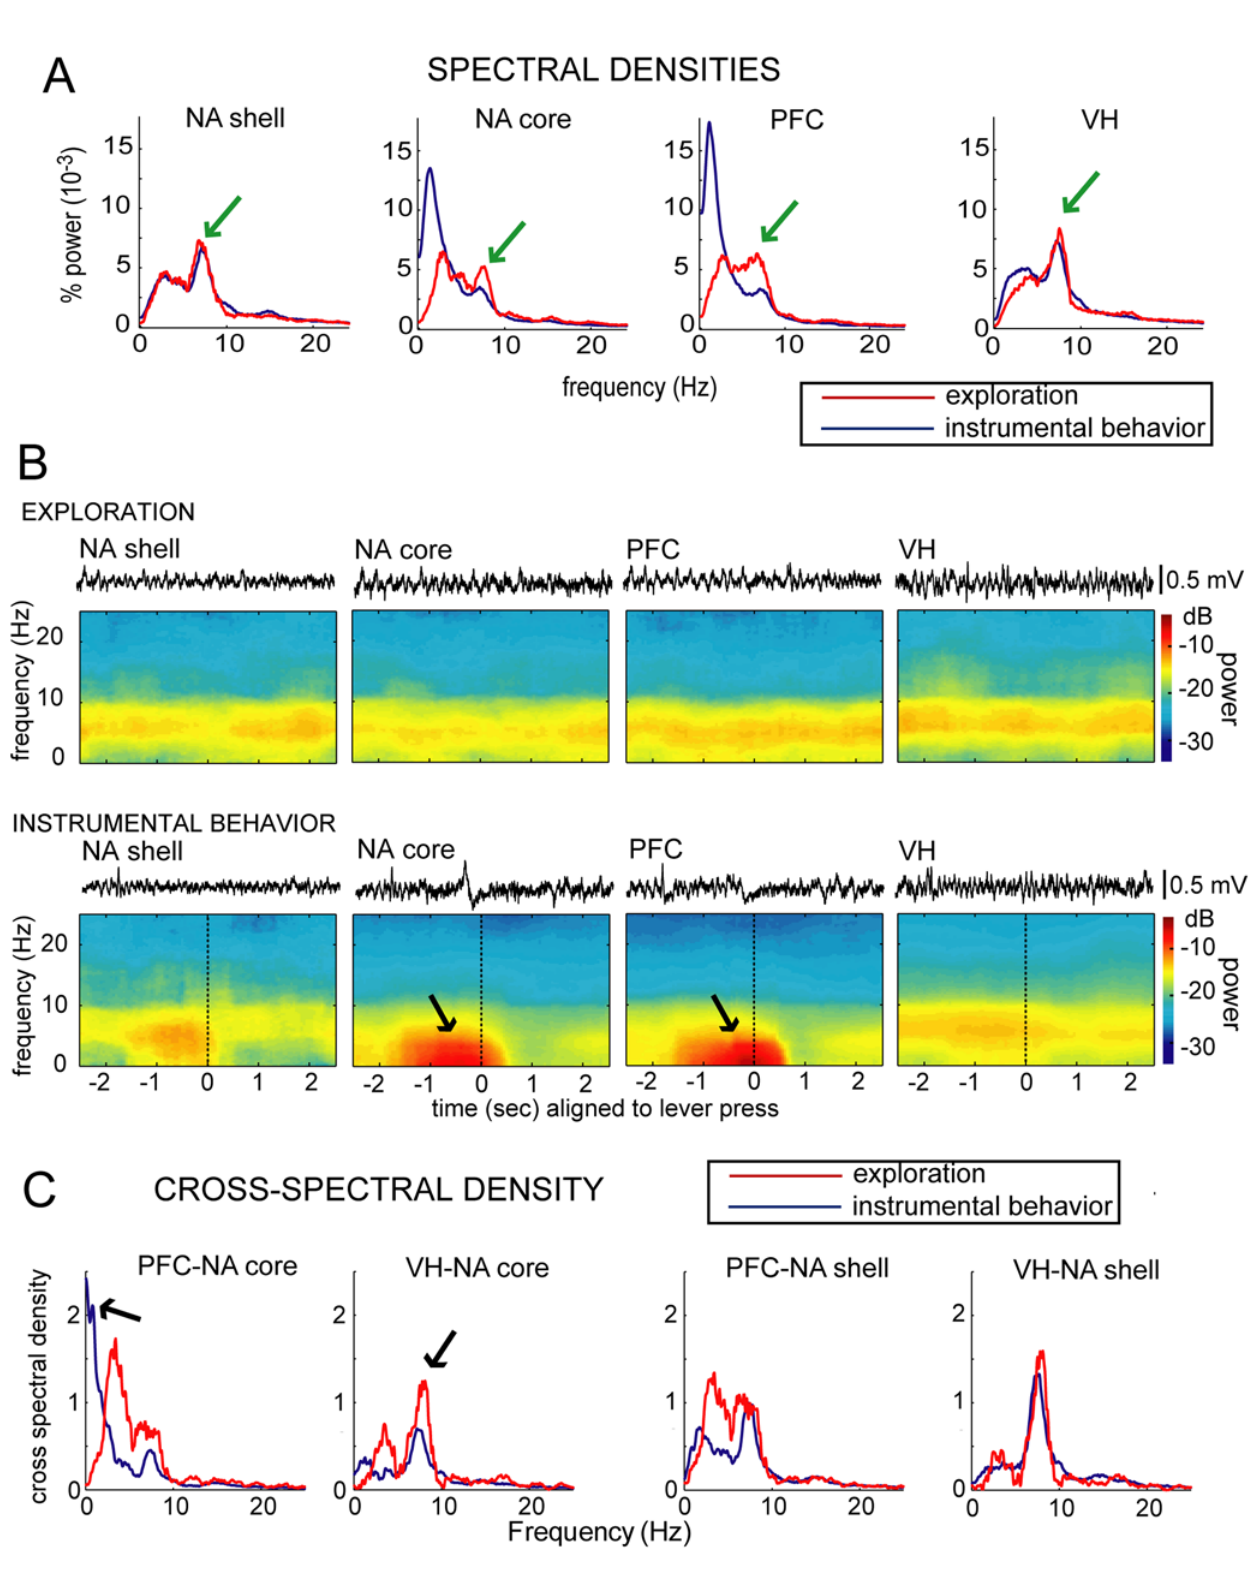
Figure 2. Dominant frequencies in the VH, NA and PFC field potentials differ between exploration and goal-directed behavior. (A) Normalized spectral densities in the NA shell, NA core, PFC and VH obtained from simultaneously recorded epochs (4 seconds) in which the animals were exploring the cage (red line). The epochs were selected to match the location and body orientation of the operant task. The blue line represents the normalized spectral densities for the same four locations but during 4 second epochs in which the rats were lever-pressing for sucrose (2 seconds prior and after the lever press). The graphs were constructed with data from 6 sessions in 5 rats for the NA core, and 2 sessions in 2 rats for the NA shell (all of them with simultaneous recordings in the PFC and VH). Strong theta peaks are evident in all regions during exploration (green arrows), but they are lost in the NA core and PFC during the instrumental behavior. An increase in delta activity can be observed instead. (B) Pseudocolor plots